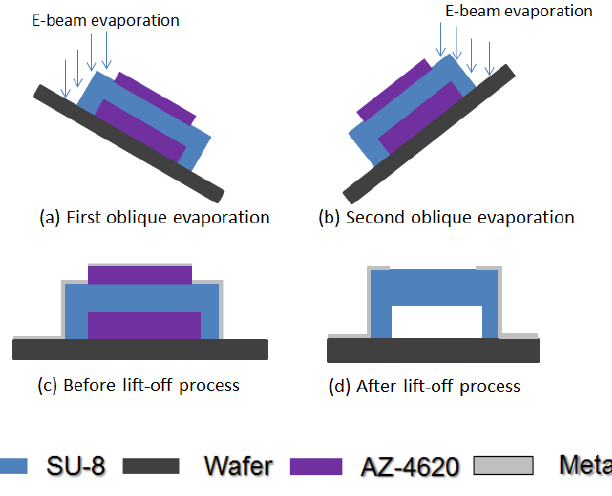
Figure 7. Schematic drawing of oblique-angle 30° e-beam evaporation and lift-off